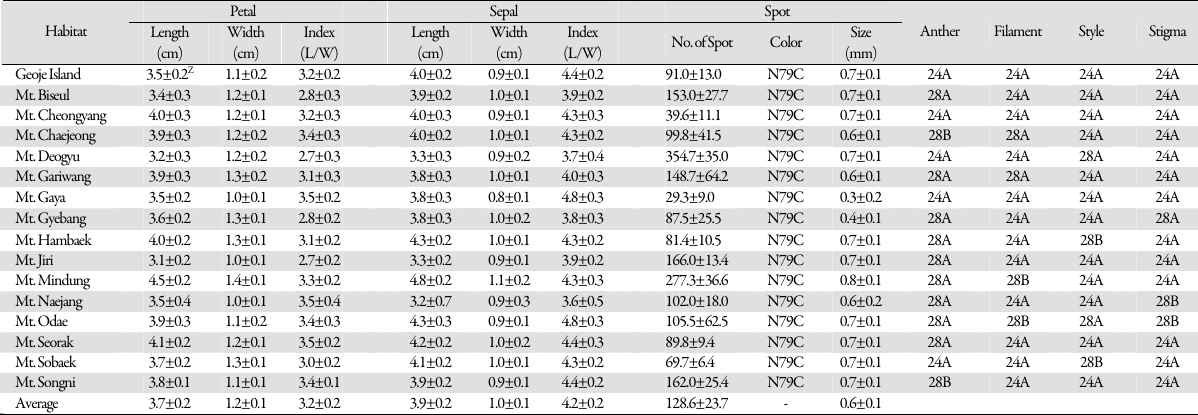
Tab. 2. Floral morphological characteristics of L. tsingtauense by region in Korea